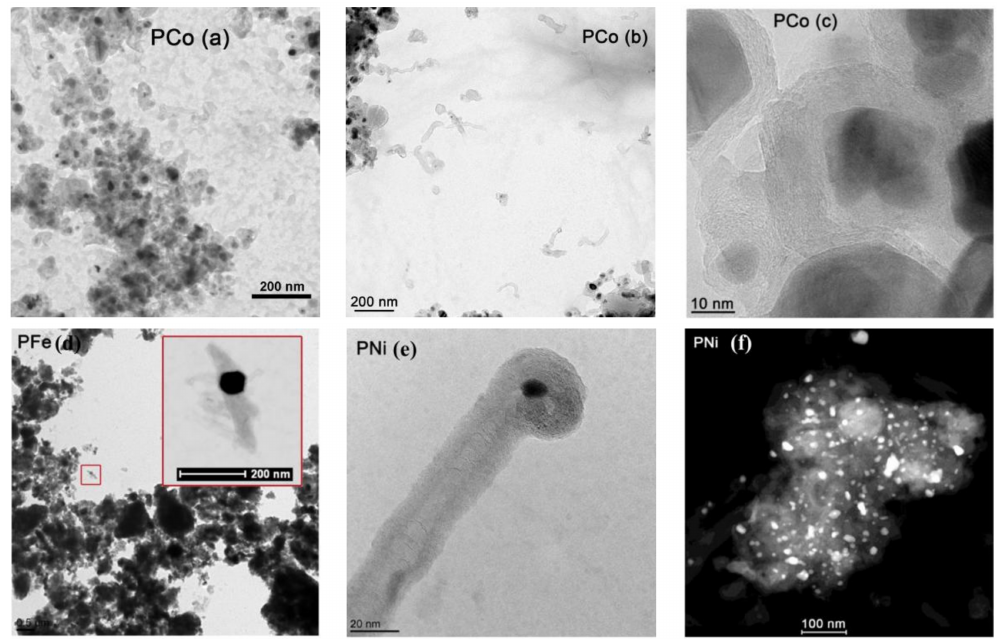
Figure 2. ( a – e ) High-resolution transmission electron microscopy (HRTEM) images of the composites; ( f ) scanning transmission electron microscopy (STEM) image, using a high angle annular dark field (HAADF) detector of the PNi